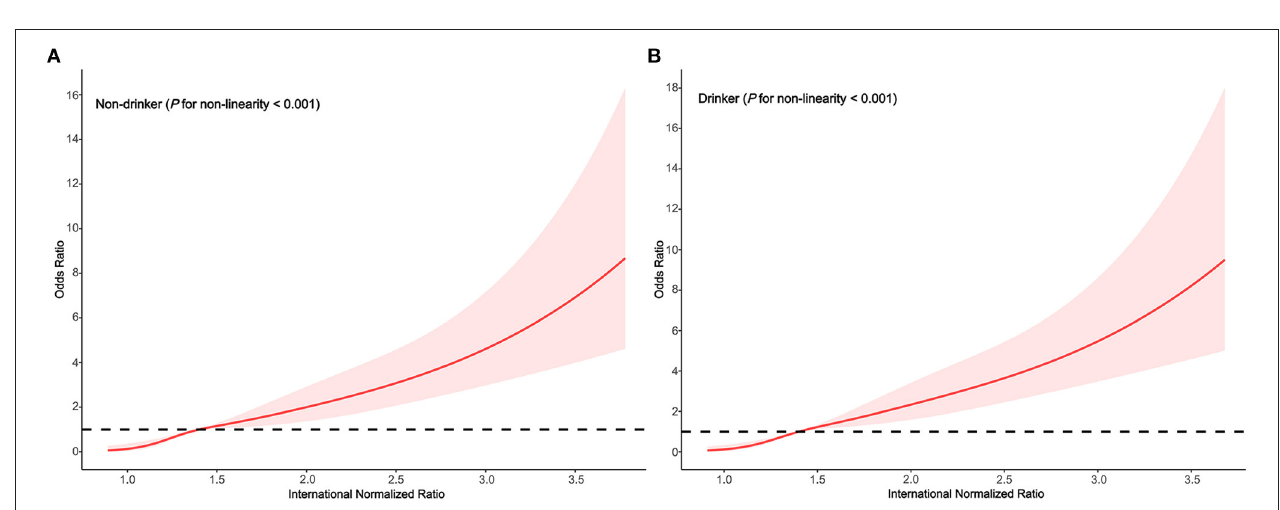
FIGURE 4 | Association between the INR and HE risk based on restricted cubic spline model stratified by smoking status (A) no; (B) yes.